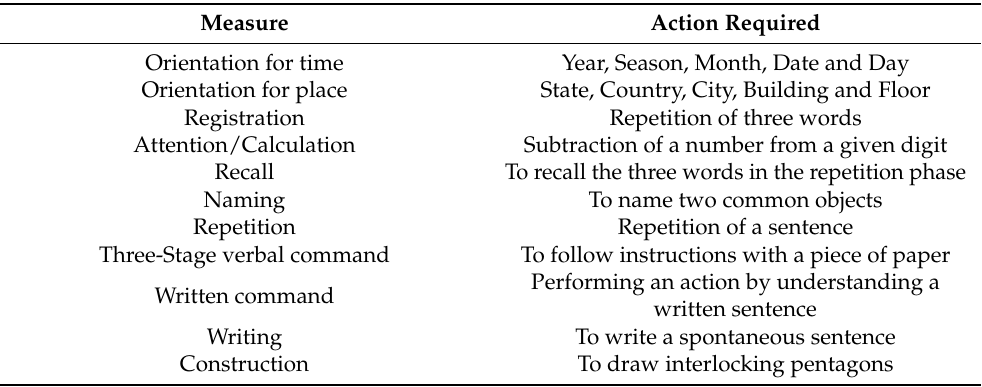
Table 1. MMSE description adapted from Galasko et al. [19]. Measure Action Required Orientation for